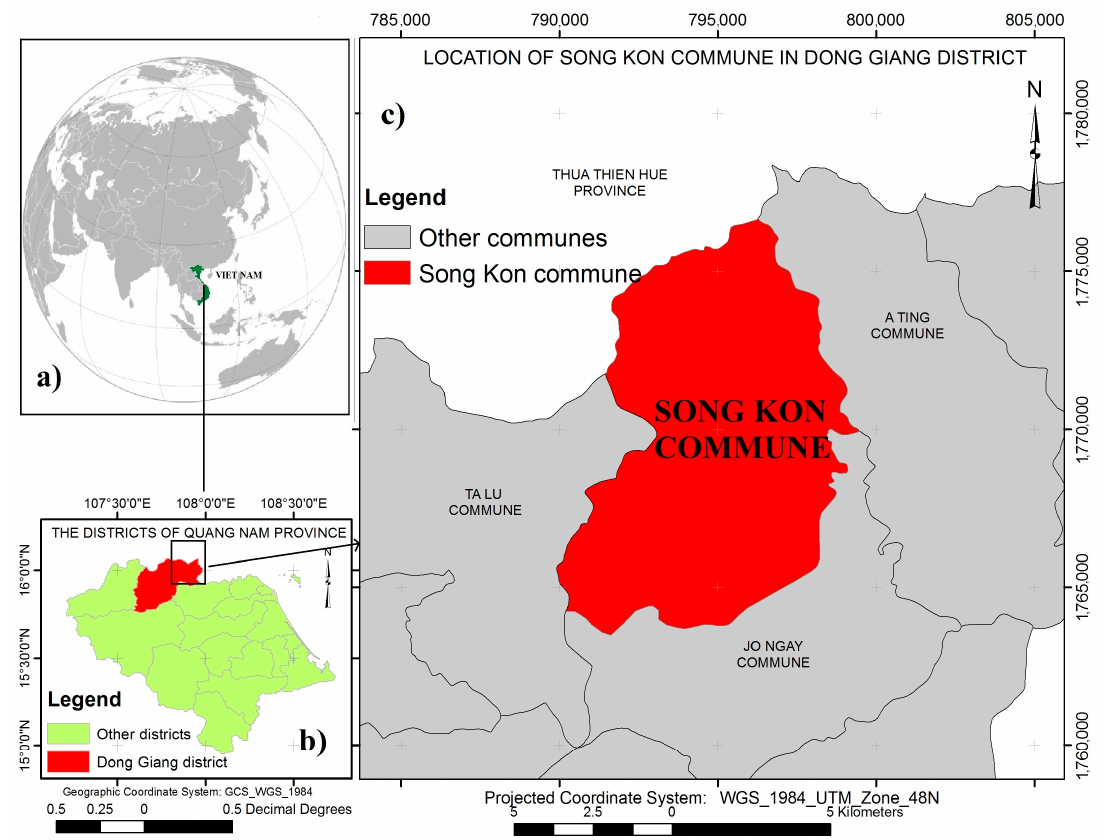
Figure 1. Map of study area; Central Vietnam ( a ); Dong Giang district in Quang Nam province ( b ) and Song Kon commune in Dong Giang district ( c ).